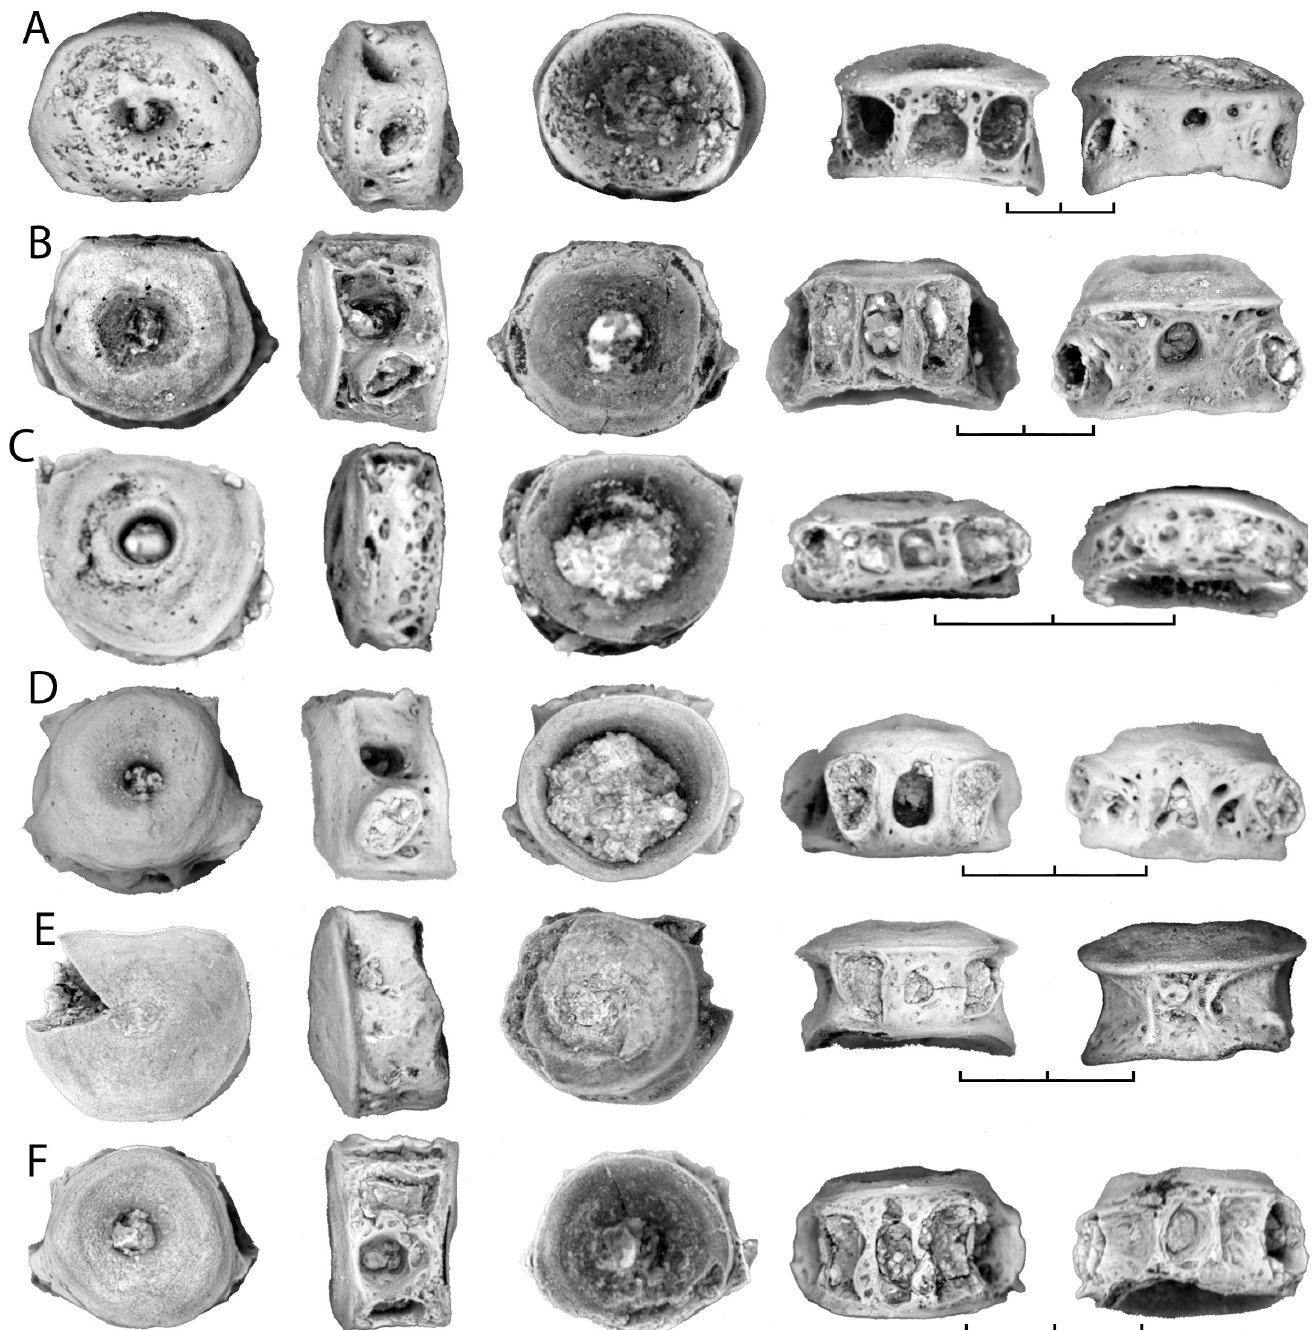
Figure 21. Precaudal centra of Teleostei indet. type O from the Milk River Formation compared with specimens from Utah. A, B) cen - tra of Teleost indet. type O from the Milk River Formation: A, anterior precaudal centrum, specimen TMP 2000.1.65; B, mid to posterior precaudal centrum, specimen UALVP 48878. C) centra of Teleost indet. type O from the Cenomanian Dakota Formation, specimen MNA V10324. D) centra of Teleost indet. type O from the Turonian Smoky Hollow Member of the Straight Cliffs Formation, specimen OMNH 31322. E, F) centra of Teleost indet. type O from the late Campanian Kaiparowits Formation: E, specimen OMNH 23786; F, speci - men OMNH 22030. Centra shown in anterior, left lateral, posterior, dorsal and ventral views. D from Brinkman et al. (2013: fig. 10.10D. Scale bar equals 2